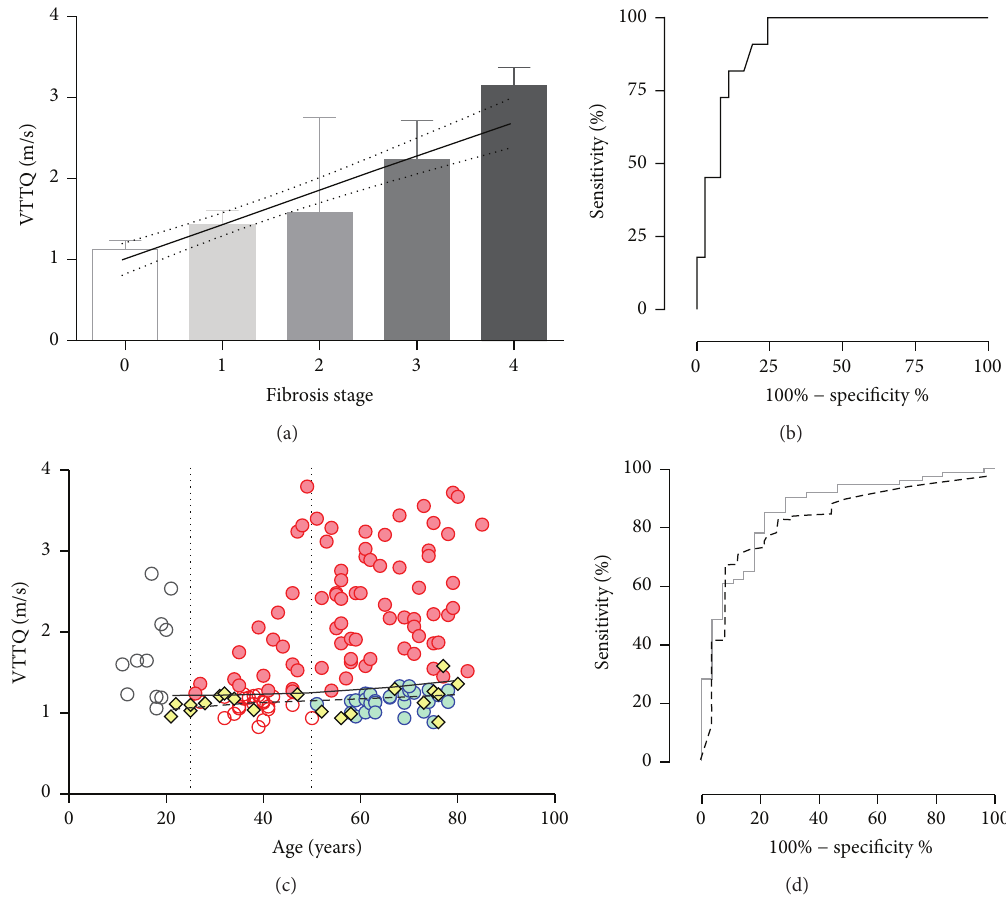
Figure 2: VTTQ and GAP-M discriminating NASH/SS suspects in NAFLD. (a) The median VTTQ and histological fibrosis stages (continuous line, best hit; dotted line, 95% confidence). (b) ROC of VTTQ distinguishing stages 0–2. (c) Four groups in VTTQ+ (see Figure 1, Normal (yellow)), Young (white), NASH suspects (red closed), SS suspects (blue), and Unspecified (red open) (continuous line, 99% confidence; dotted line, best hit). (d) AUROCs for GAP-M to distinguish NASH suspects from SS suspects (grey continuous line) or to distinguish histologically proven NASH from SS (black dotted